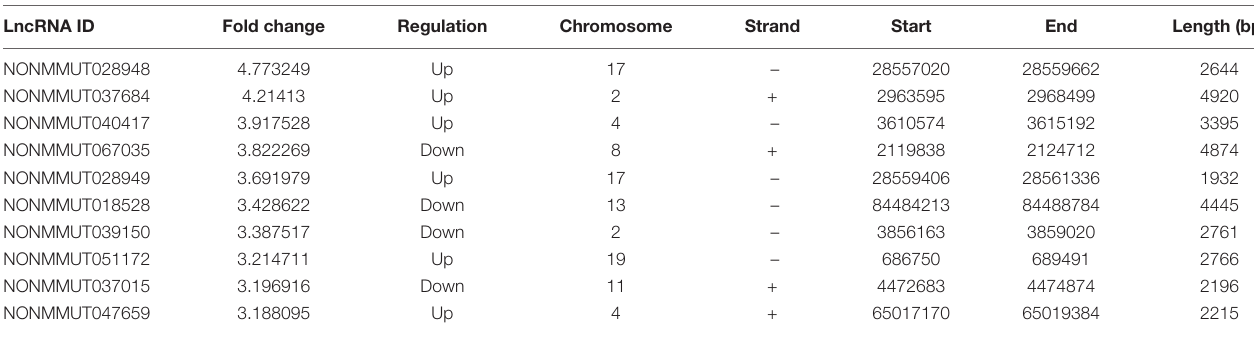
FIGURE 1 | Clusters of differentially expressed LncRNA and mRNA of NSCs. (A) A total of 63 LncRNAs were differentially expressed in MP treated NSCs ( n = 3) compared with control NSCs ( n = 3). Hierarchical clustering showed a distinguishable LncRNA expression profile. (B) A total of 174 mRNAs were differentially expressed in MP treated NSCs ( n = 3) compared with control NSCs ( n = 3). Hierarchical clustering showed a distinguishable mRNA expression profile. TABLE 1 | The top 10 differentially expressed